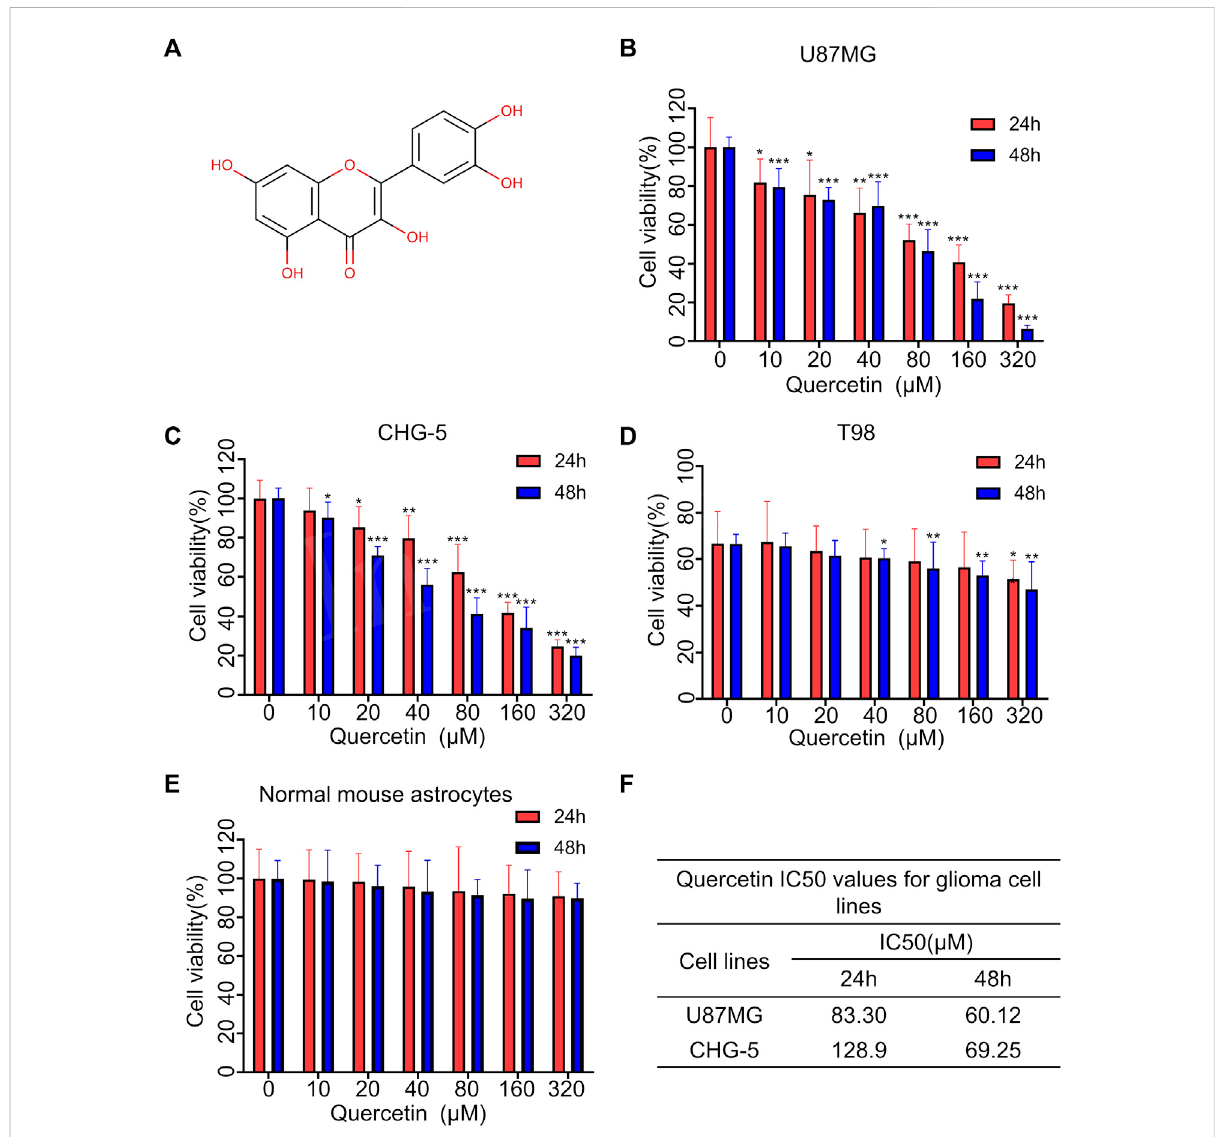
FIGURE 1 Quercetin inhibited the proliferation of glioblastoma cells in vitro . (A) The chemical structure of Quercetin. (B – D) Three glioma cell lines U87MG, CHG-5 and T98 were treated with various concentrations of Quercetin for 24 and 48 h, respectively, then the cell viability was measured withCCK-8. (E) Cytotoxiceffectsofquercetin.Normalmouseastrocytesweretreatedwithvariousconcentrationsofquercetinfor24and48h,then the cell viability was measured with CCK-8. (F) Quercetin IC50 values for glioma cell lines. All data are shown as the mean ± SD of six experiments. *p ＜ 0.05, ** p ＜ 0.01 or ***p ＜ 0.0 01 vs. control